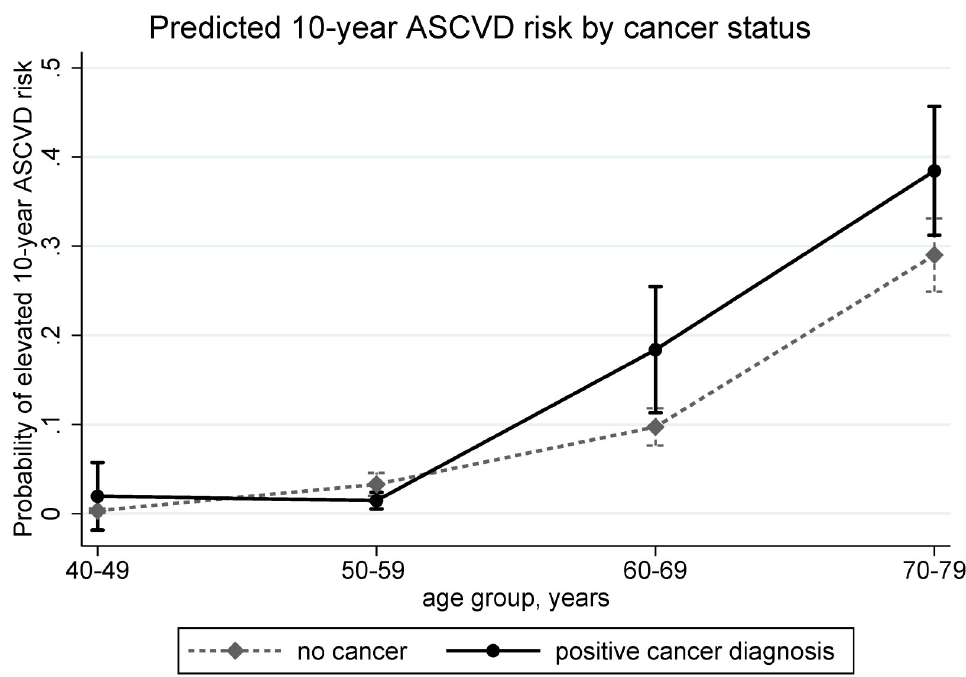
Fig 2. Estimated population-weighted probability of elevated 10-year ASCVD risk (PCEs � 7.5) between participants with and without cancer diagnosis, according to age groups, based on logistic regression adjusted for BMI, marital status, education level, income to poverty ratio, dietary intake, physical activity, and depression score.